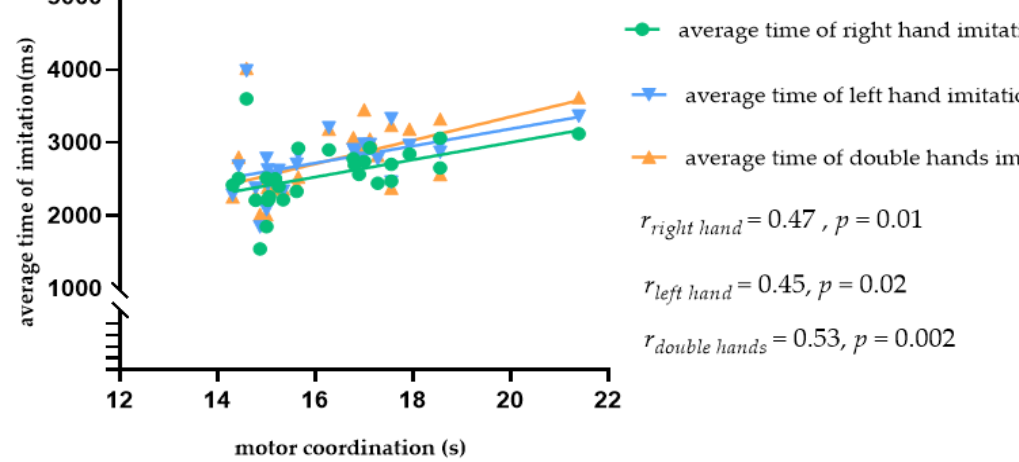
Figure 5. Scatter plot showing the relationship between motor coordination and the average imitation time in female